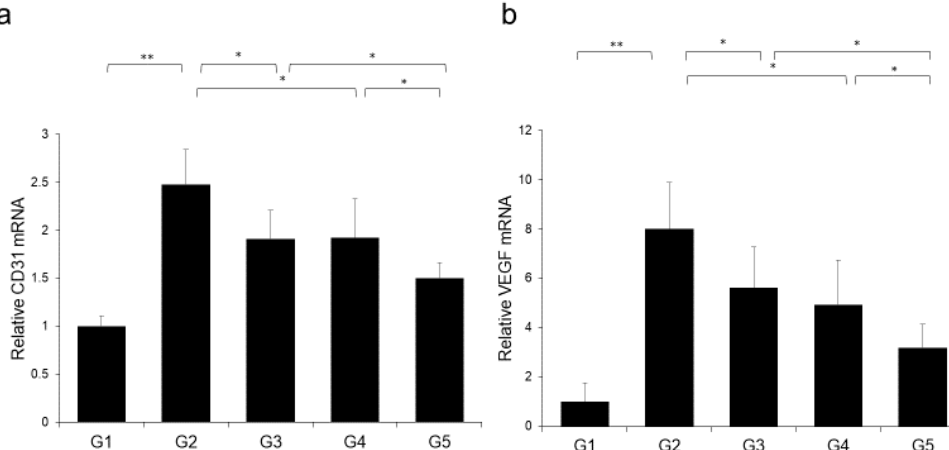
Figure 7. Effects of canagliflozin (CA) and teneligliptin (TE) on hepatic ( A ) CD31 mRNA expression and ( B ) hepatic vascular endothelial growth factor (VEGF) protein expression. G1, Group 1 (choline-sufficient, L-amino acid-defined diet); G2, Group 2 (choline-deficient, L-amino acid-defined diet (CDAA)); G3, Group 3 (CDAA+ canagliflozin (CA)); G4, Group 4 (CDAA+ teneligliptin (TE)); G5, Group 5 (CDAA+CA+TE); Values represent mean ± SD ( n = 10). * p < 0.05, ** p < 0.01.